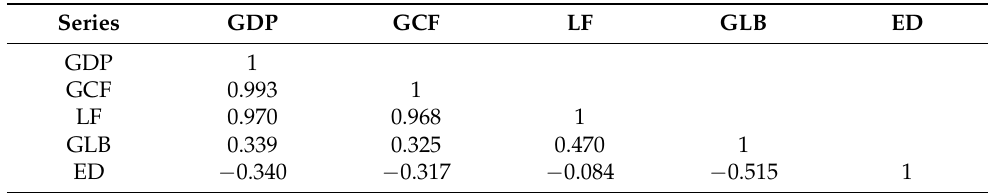
Table 2. Unconditional correlations among the